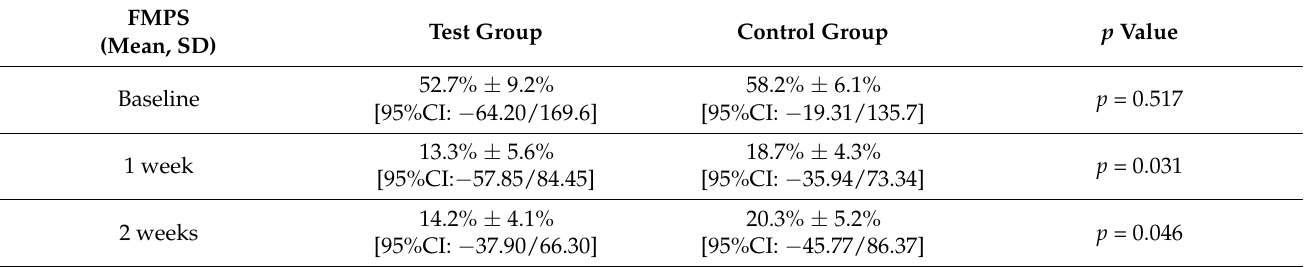
Table 2. FMPS, FMBS, and Gingival Index assessment of the Test and Control Group at the baseline, after 1 week, and 2